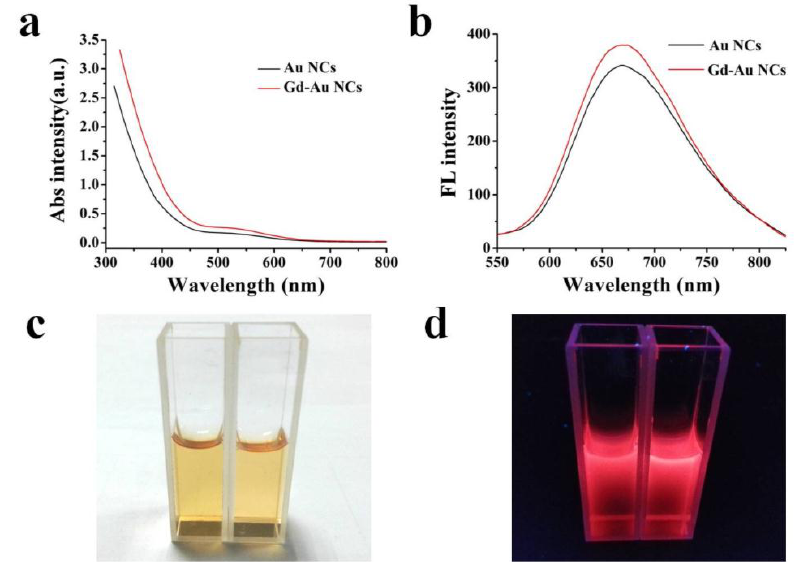
Figure 2. ( a ) Ultraviolet–visible absorption spectra of Au nanoclusters (NCs) (black curve) and Gd-Au NCs (red curve), Abs (Absorbance), a.u. (Absorbance Unit); ( b ) The corresponding fluorescent emission spectra of Au NCs (black curve) and Gd-Au NCs (red curve); ( c ) Bright photograph of Au NCs (left) and Gd-Au NCs (right); ( d ) The corresponding fluorescent photograph of Au NCs (left) and Gd-Au NCs (right) was taken under a porTable 365 nm UV-lamp (Min hang, Shanghai, China).